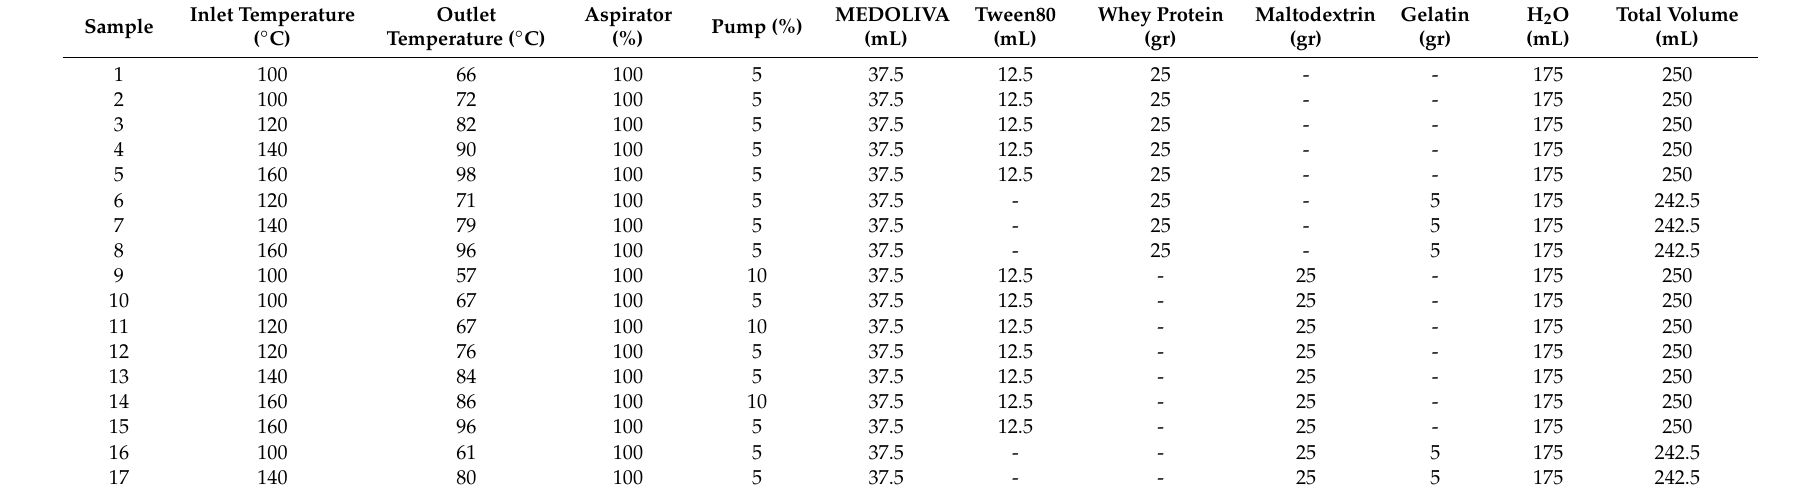
Table 1. The tested powders and their encapsulation